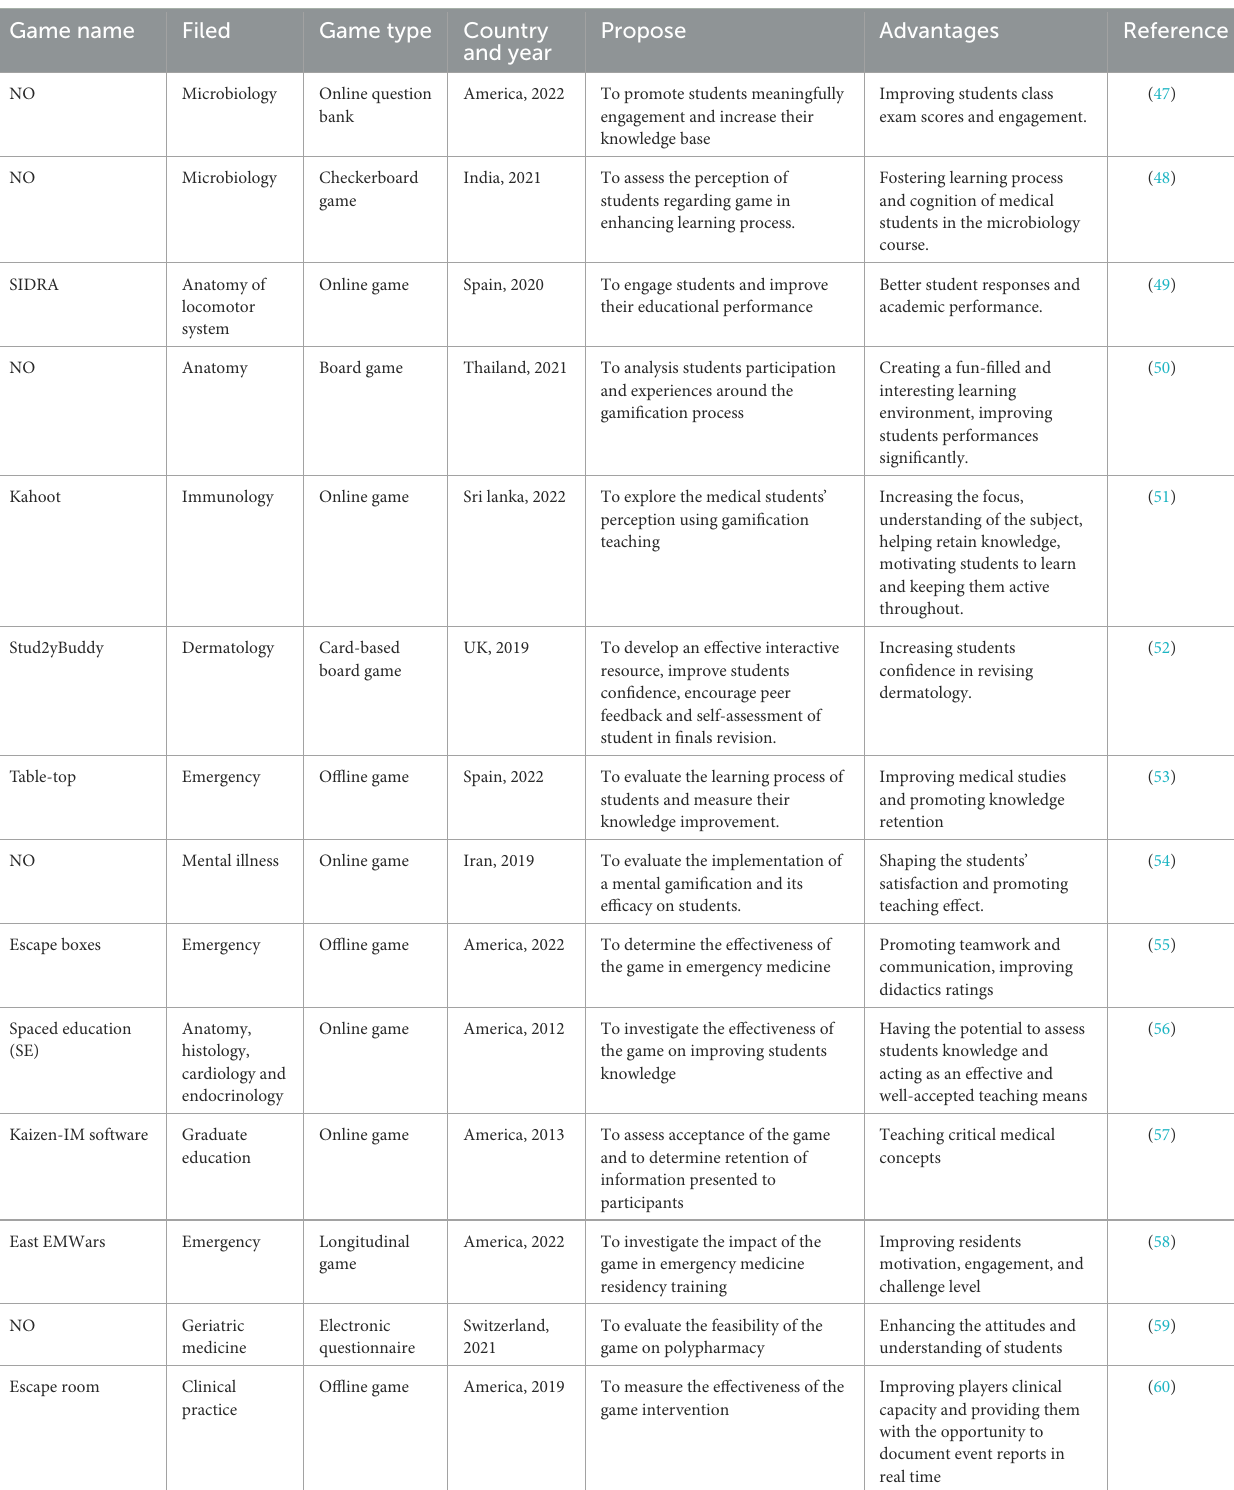
TABLE 2 Gamification in medical teaching